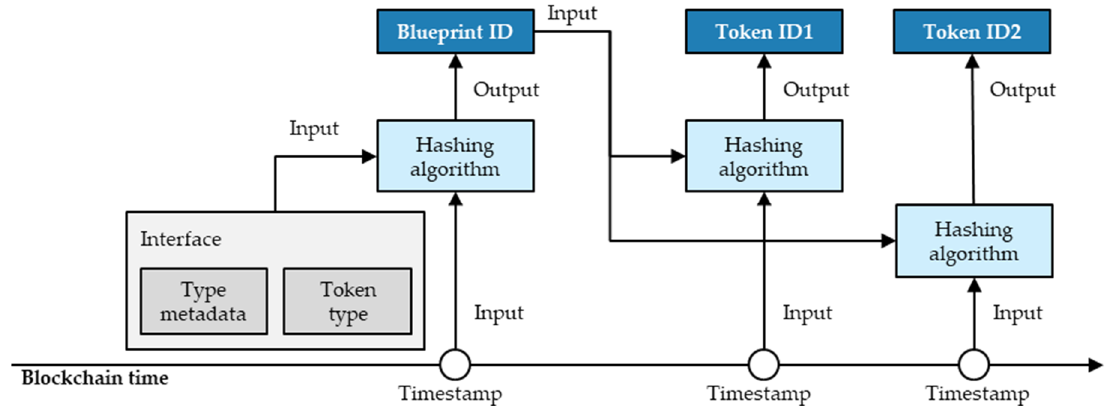
Figure 5 . Hashing mechanism for creating NFTs of the same type. Figure 5. Hashing mechanism for creating NFTs of the same